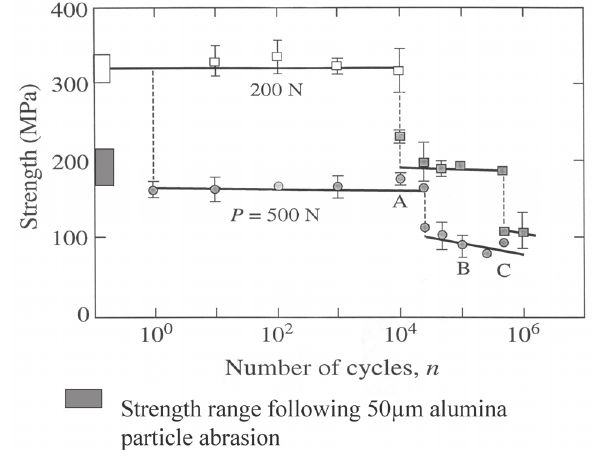
FIGURE 10 - Hertizian contact flexural fatigue strength the lass-ceramic, Dicor. Tested as shown in Figure 1. The for R red bar indicates the strength following 50 µm alumina particle abrasion